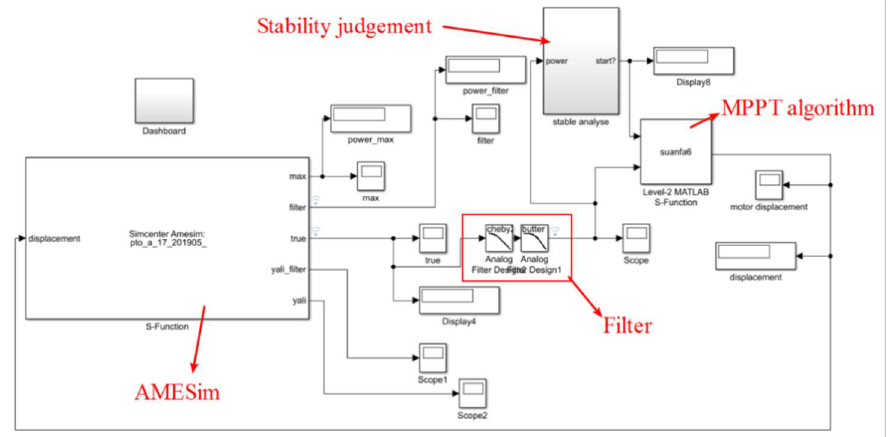
Figure 8. The diagram of simulation in Simulink, including modules of AMESim, stability judgment, filter and the MPPT algorithm compiled by MATLAB.